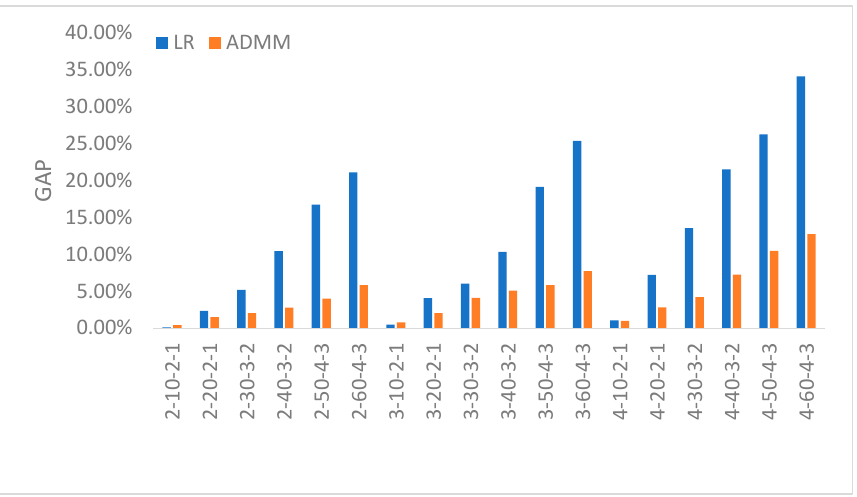
Figure 9. Comparison of ADMM and LR solution gaps.